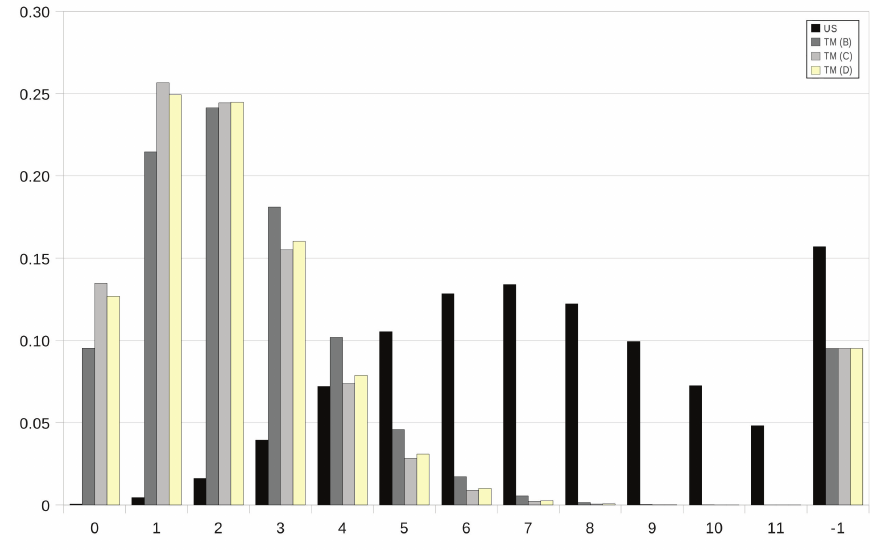
Figure 6. The mass function of the parasite burden M ( τ ) at age τ = 1 year. Scenario US and grazing strategy TM with the anthelmintics ivermectin, fenbendazole and albendazole (from left to right) as the intervention prescribed at ages t 0 = 170, 273 and 272,